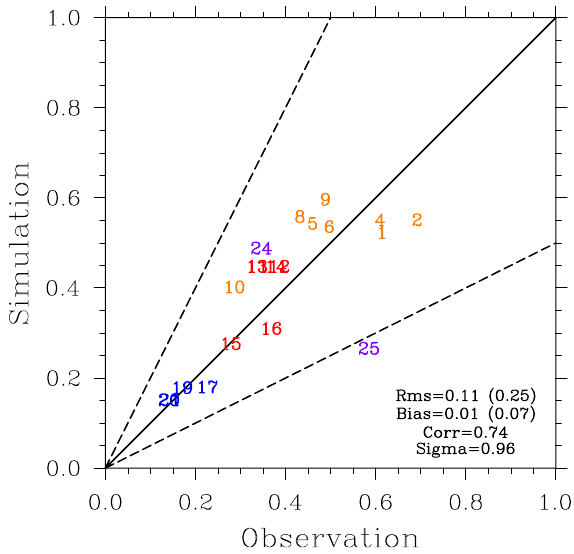
Fig. 16. AOD comparison between AERONET measurements and CanAM4-PAM results at “dusty” sites. The locations of “dusty” sites are shown in Fig. 4: Middle East (red), Africa (orange), Caribbean-America (blue) and elsewhere in the world (purple). Name, latitude and longitude of each site are listed in Table 4. Root mean square error (Rms), bias, correlation (Corr) and ratio of mod- elled to observed standard deviation (sigma) are indicated. Normal- ized root mean square error and mean normalized bias are given in the parenthesis next to Rms and Bias. Black solid line is the 1 : 1 line and black dash lines are 2 : 1 and 1 : 2 lines. Sites 3, 7, 18, 22 and 23 are not shown because of the lack of data in the period